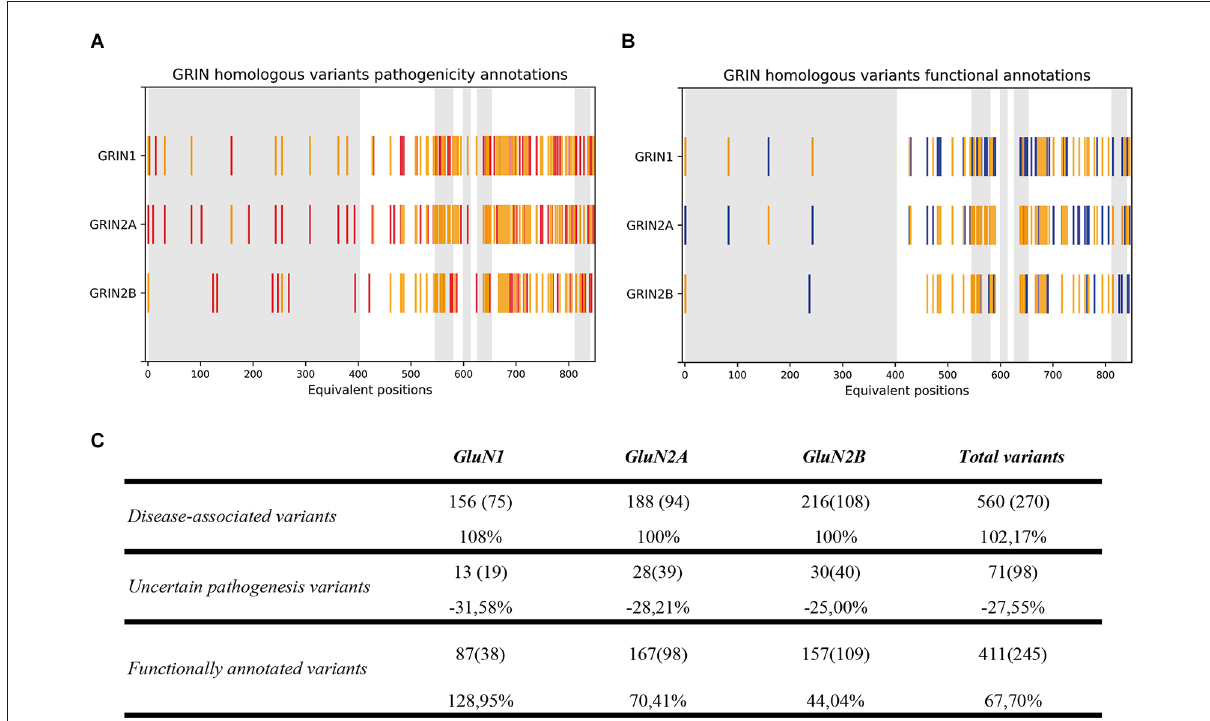
FIGURE3 (A) GluN variants pathogenicity annotations based on current annotations (in red) and on GRIN structural algorithm-inferred annotations from homologous variants (in yellow). (B) GluN variants functional annotations based on current available annotations (in blue) and GRIN structural algorithm-inferredannotationsfromhomologousvariants(inyellow). (C) SummaryofGRINstructuralalgorithm-basedcomputationalannotation of non-classified GluN1, GluN2A, and GluN2B subunits missense variants. GRIN predictive power of the algorithm was applied, and showed an expansion of disease-associated (top row) GRIN variants, together with a reduction of GRIN variants number previously classified as “Uncertain significance” (central row) and an increase of functional annotations of GRIN variants affecting the ATD, LBD, and TMD domains (bottom